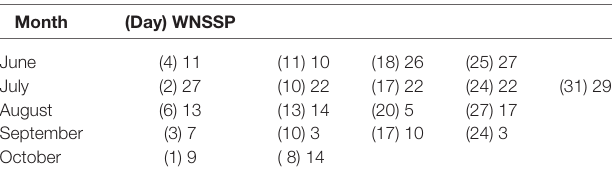
TABLE 1 | Weekly scores from the Western Neuro Sensory Stimulation Profile (WNSSP) commonly used to track changes in neural sensory processing